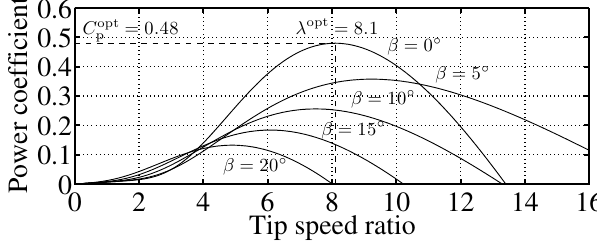
Figure 2. C p - λ curve of wind